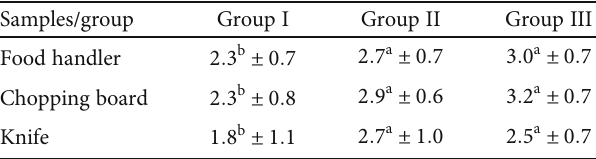
Table 5: Hygiene practices and microbial quality in restaurants among groups based on Total Aerobic Bacterial Count (log cfu/cm 2 ).